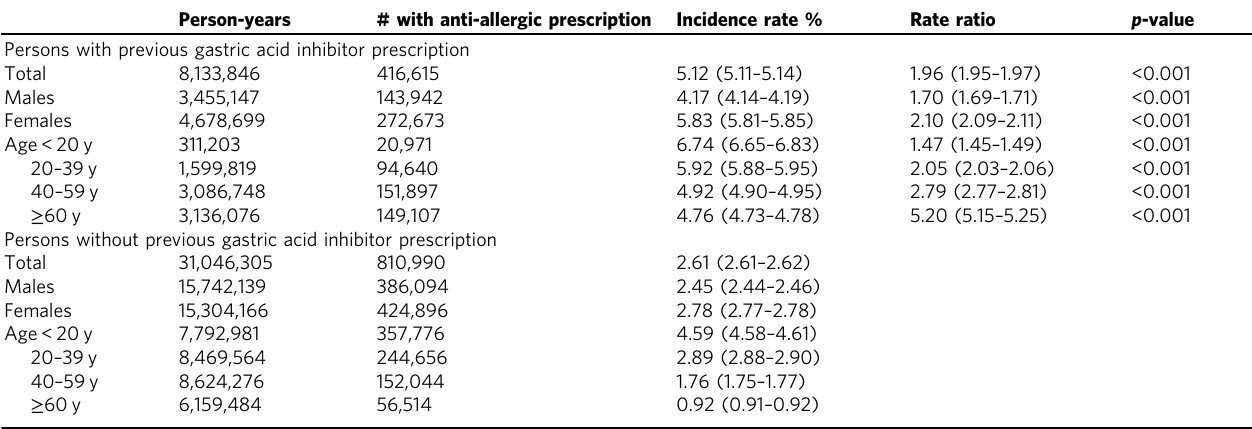
Incidenceratesand95%con fi denceintervals(CI)ofanti-allergicdrugprescriptionsinindividualswithandwithoutacidinhibitormedicationfromdataofoverallAustriaandrateratiosforananti-allergic drug prescription in individuals with acid inhibitor medication relative to those without. p values based on Wald chi-square test